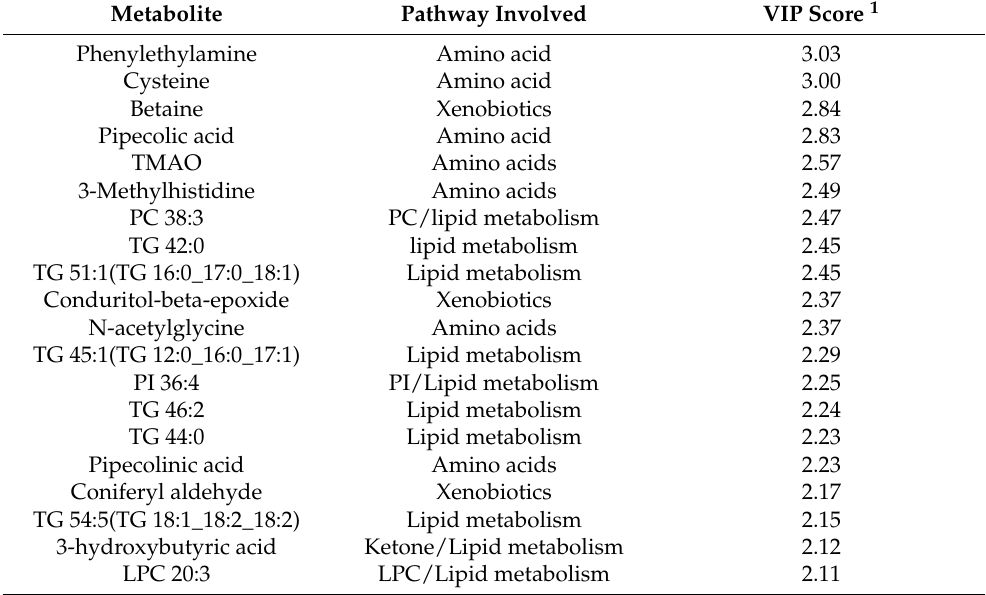
Table 2. Top 20 metabolites with the highest Variable Importance in Projection (VIP) 1 score.